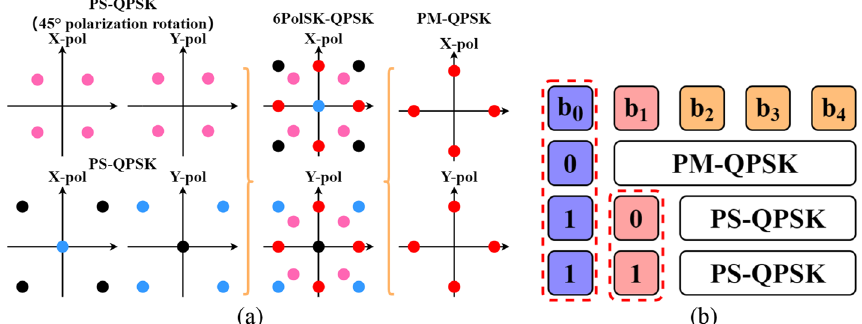
Fig. 1 a Polarization states ( X and Y ) of PS-QPSK, 6PolSK-QPSK, PM-QPSK. b The coding rule of 32-Point